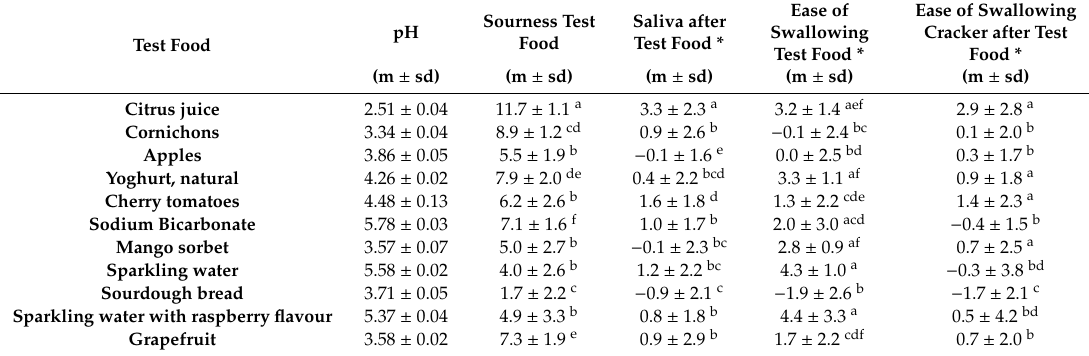
Table 1. Results for pH, perceived sourness, saliva level, and ease of swallowing. Di ff erent letters in the same column indicate significant di ff erences between samples at p ≤